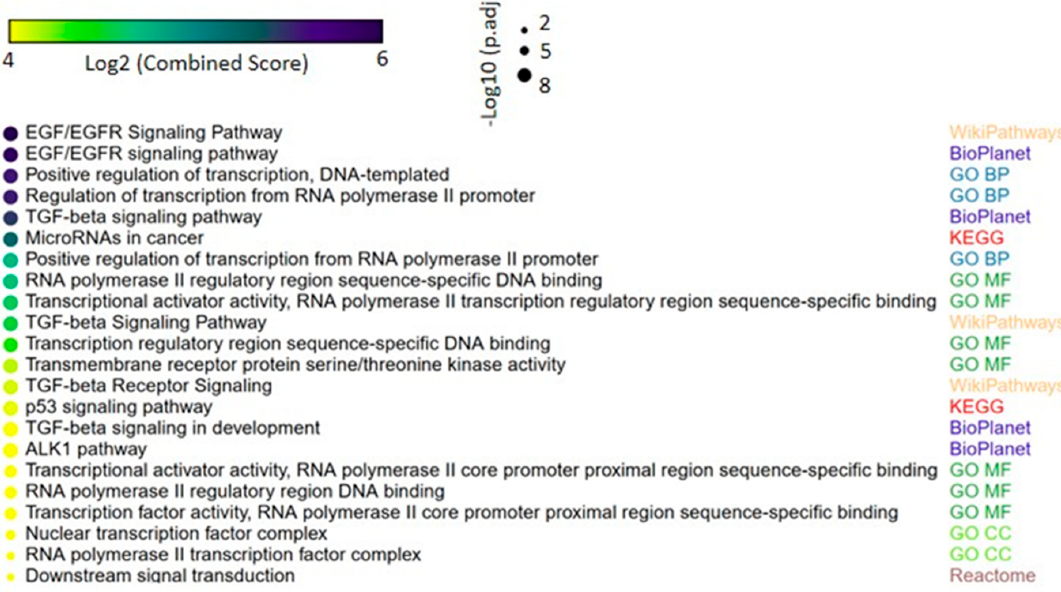
Figure 5. Gene set enrichment analysis of the predicted miRNA-target genes in lung cancer. Up to four of most significant terms from each of the following collections are shown: Kyoto Encyclopedia of Genes and Genomes (KEGG), WikiPathways, BioPlanet, Reactome, Gene Ontology (GO) biological process, GO molecular function and GO cellular component. The size and the color in the heat-scatterplot represent the combined score and the corresponding adjusted p -values, respectively, from the enrichment significance of each gene set, as computed by EnrichR [15,16].